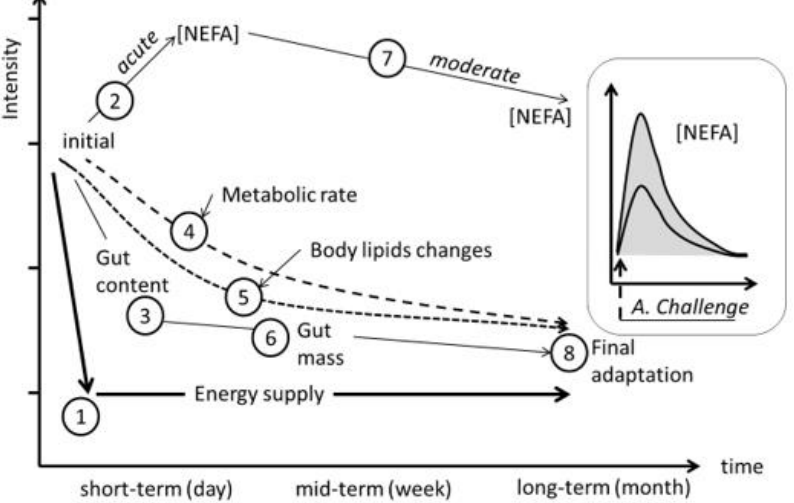
Figure 7. Schematic representation of the encompassing chain of short-, medium- and long-term reactions of a ruminant when facing a drastic feed (energy) shortage. NEFA = nonesterified or free fatty acids.